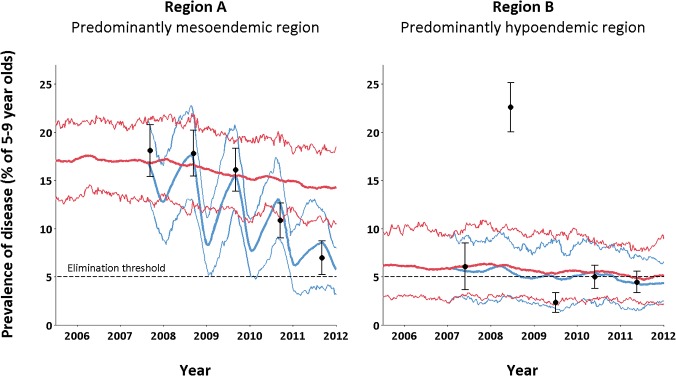
The epidemiological effect of past intervention efforts on disease prevalence amongst 5–9 year old children in two de-identified remote Australian regions.The thin blue curves represent the 90% inter-percentile range of 1,000 model simulations with the past intervention effort applied as empirically recorded. The thick blue curve illustrates the mean simulation. The corresponding red curves describe the hypothetical scenario that a trivial intervention effort was observed. The black dots represent the weighted disease prevalence levels of 5–9 year old children found through annual screening events in each of the at-risk communities modelled within the specific region. Accompanying each of the observed prevalence points is a 95% confidence interval which reflects the regional screening coverage achieved in the given year. The extreme 2008 prevalence in the right hand figure is likely due to the temporary mass migration of individuals [28].